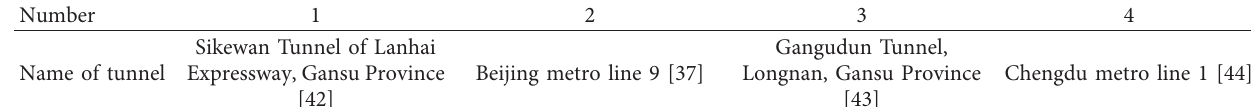
Table 2: Statistics of tunnel construction in cobble and sandy-cobble